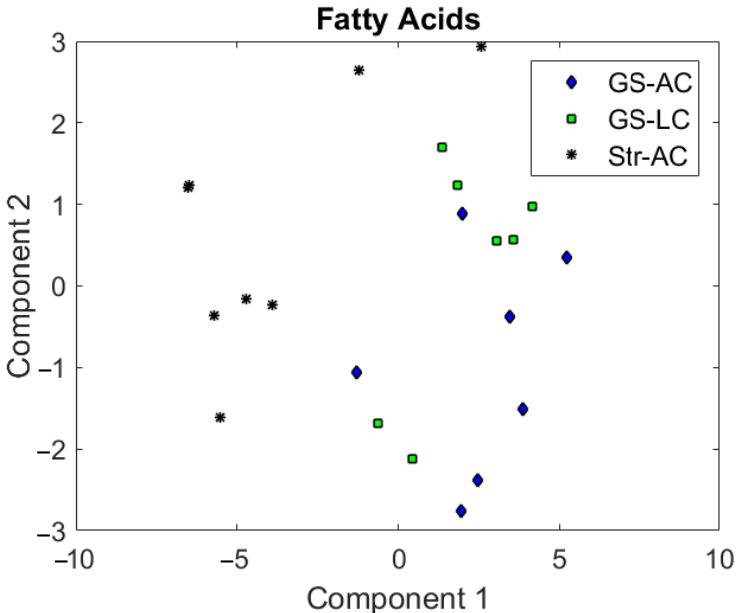
Figure 1. Principal component score plot using the main fatty acids (>0.4% on total fatty acids) as variables. GS-AC = grass silage plus concentrate ad libitum; GS-LC = grass silage plus restricted concentrate; Str-AC = barley straw plus concentrate ad libitum.